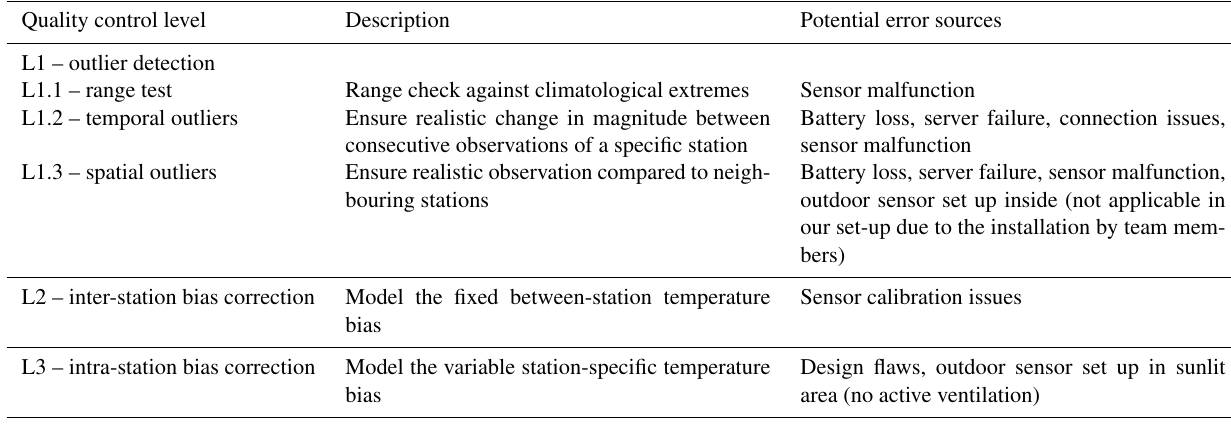
Table 6. Parameter settings for QC level 1 – outlier detection. Outlier parameter Value (unit)